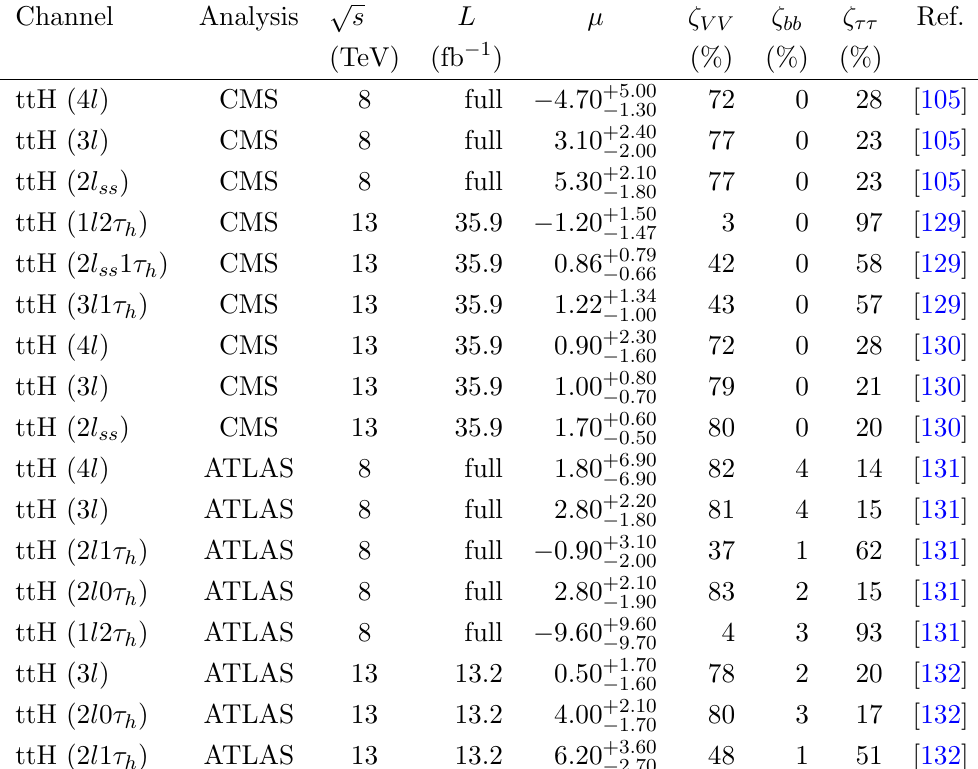
Table 2 . Signal strength for ttH multi-lepton searches (cid:22) f for current LHC data. (cid:16) V V , (cid:16) bb , and (cid:16) (cid:28)(cid:28) indicate weights in the Higgs decays into WW plus ZZ , b (cid:22) b , and (cid:28) + (cid:28) (cid:0) , respectively. O(cid:14)cial values for weights are used when given. \2 l ss " stands for two same-sign